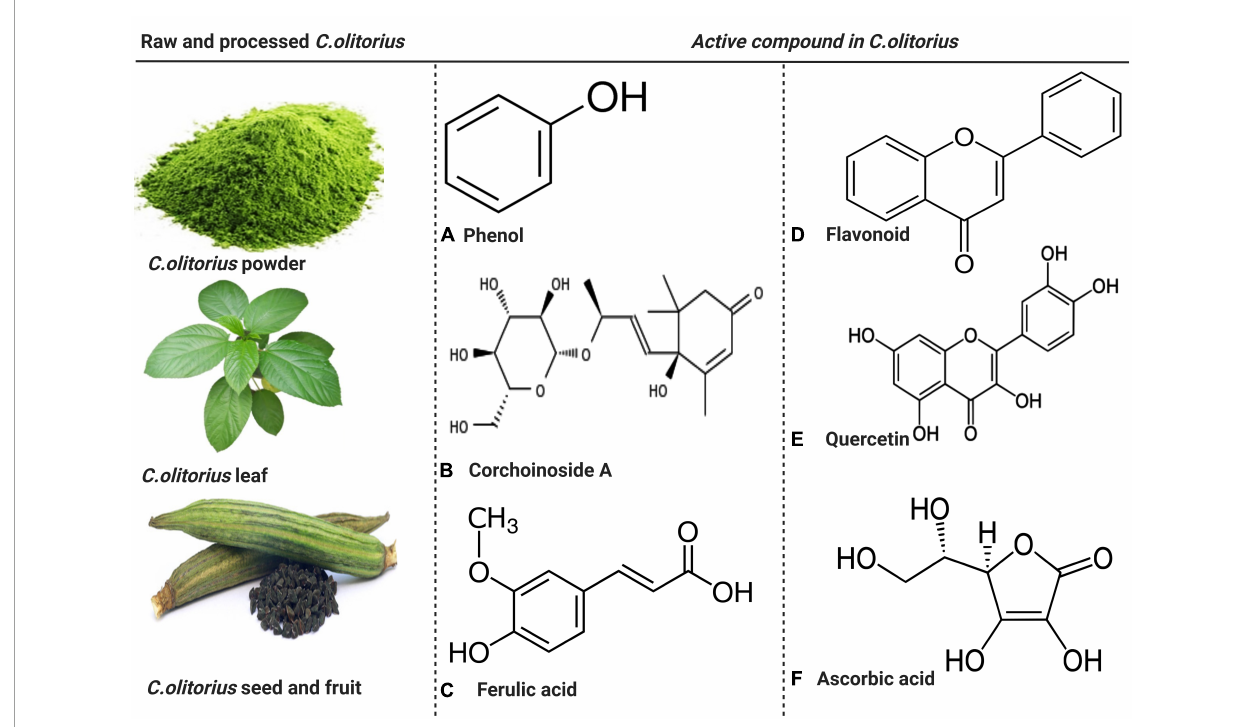
FIGURE2 The raw and processed parts of Corchorus olitorius and active compound present in C. olitorius . Both raw and processed Corchorus olitorius contains active compounds such as phenol, corchoinoside A, ferulic acid, flavonoids, quercetin, and ascorbic acid.